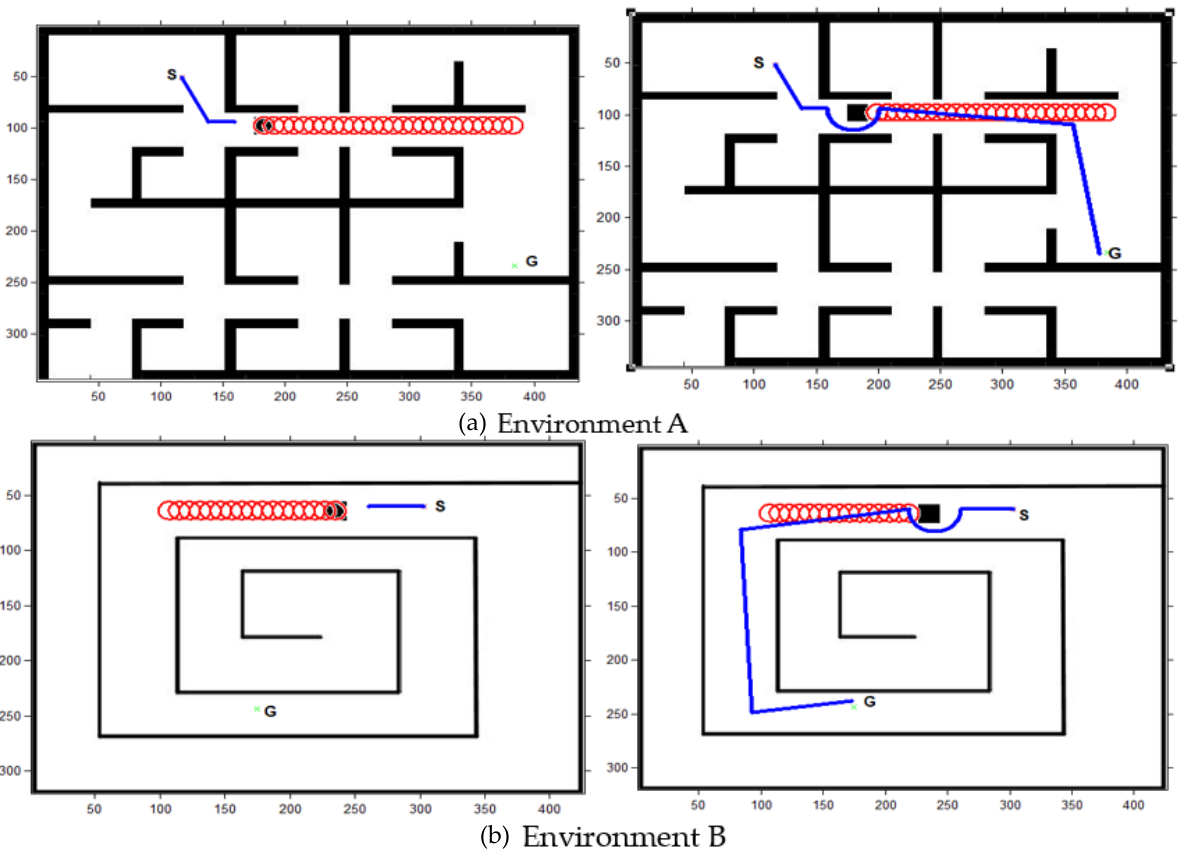
Figure 13. Dynamic obstacle avoidance: ( a ) Environment A, ( b ) Environment B.